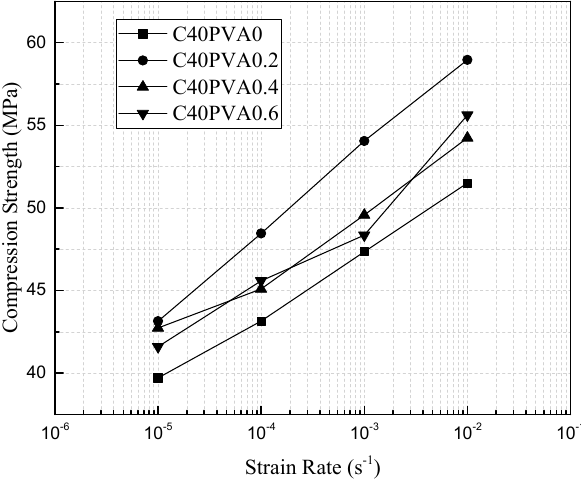
Figure 4. The uniaxial compressive strength of FRC (C40).